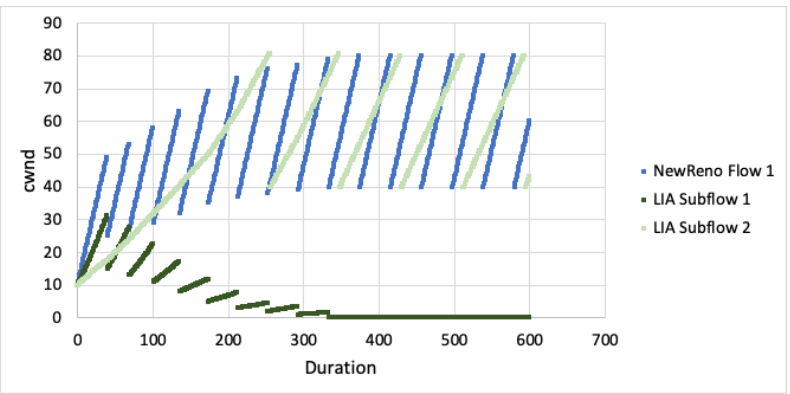
Figure 12. LIA—Competing Window Growth— Subflow 1 RTT = x , Subflow 2 RTT = 2 x .